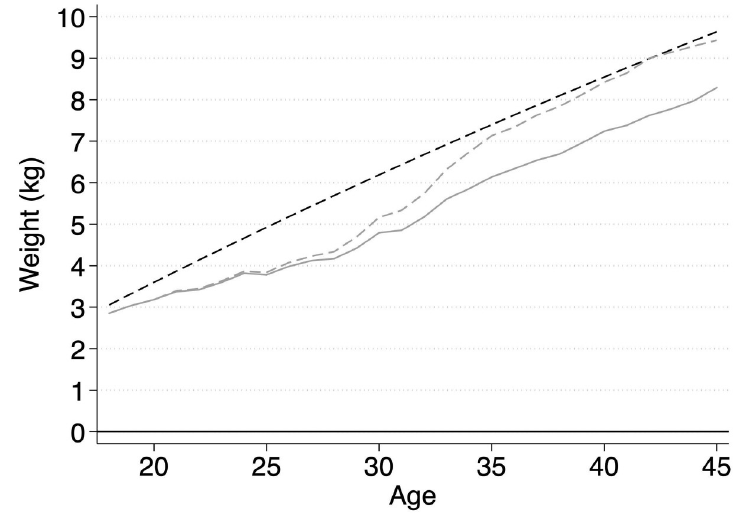
Fig 4. Predicted differences in body weight between lower and higher educated women with and without adjustment for motherhood. SOEP data, v.34; own calculations; height is fixed at the average of 167 cm in both models; black solid reference line = body weight of higher educated women, black dashed line = difference in body weight between lower educated women and higher educated women based on model M1, Table 2; grey dashed line = difference in body weight between lower educated women and higher educated women adjusted for differences in prevalence of motherhood; grey solid line = difference in body weight between lower educated women and higher educated women adjusted for differences in prevalence and effects of motherhood (M3), Table